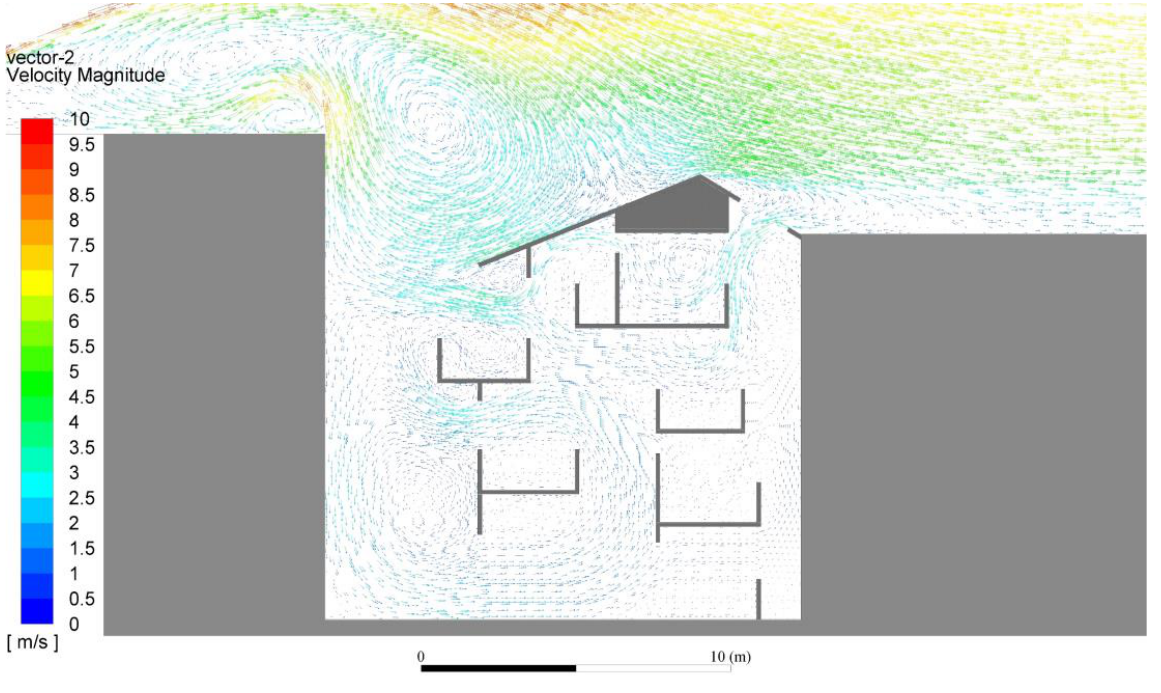
Figure 26. 2D CFD test of the design building section (simulated by the students).